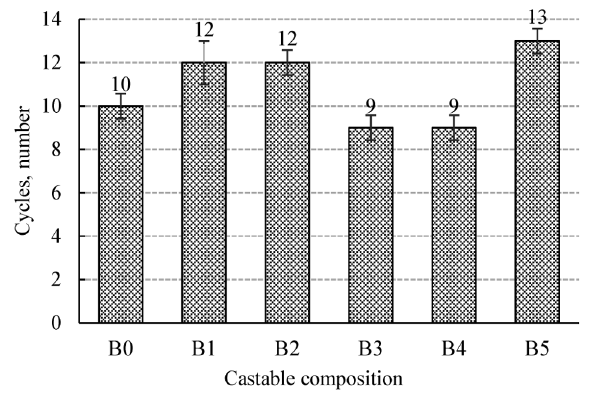
Fig. 5. Thermal shock resistance of refractory castable samples after heating-cooling, the number of